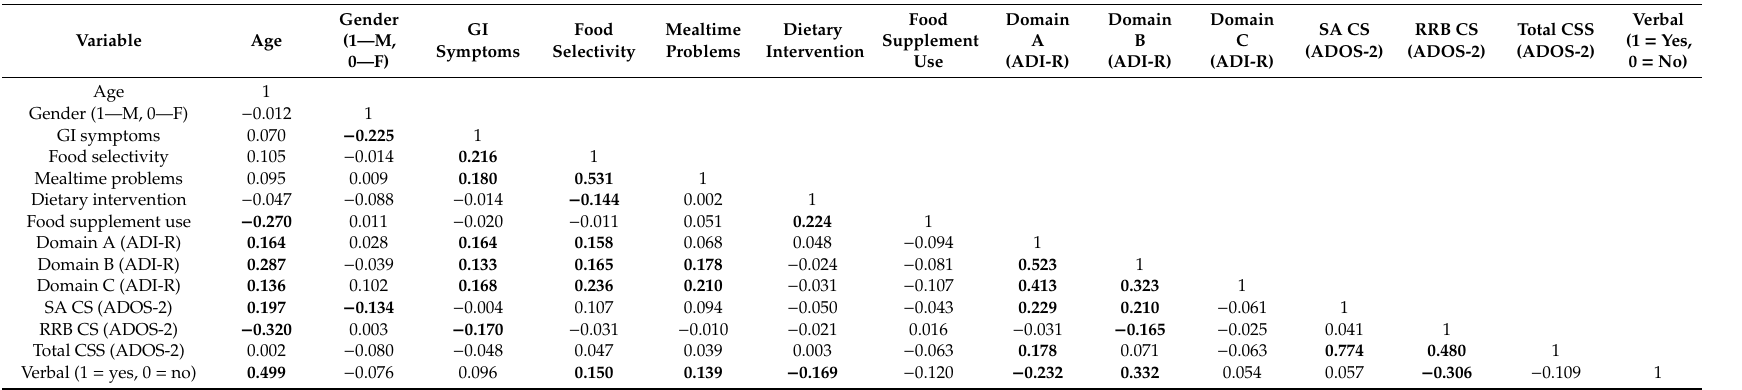
Table 8. Correlation matrix based on pairwise Spearman correlation coe ffi cients ( ρ ) in the ASD